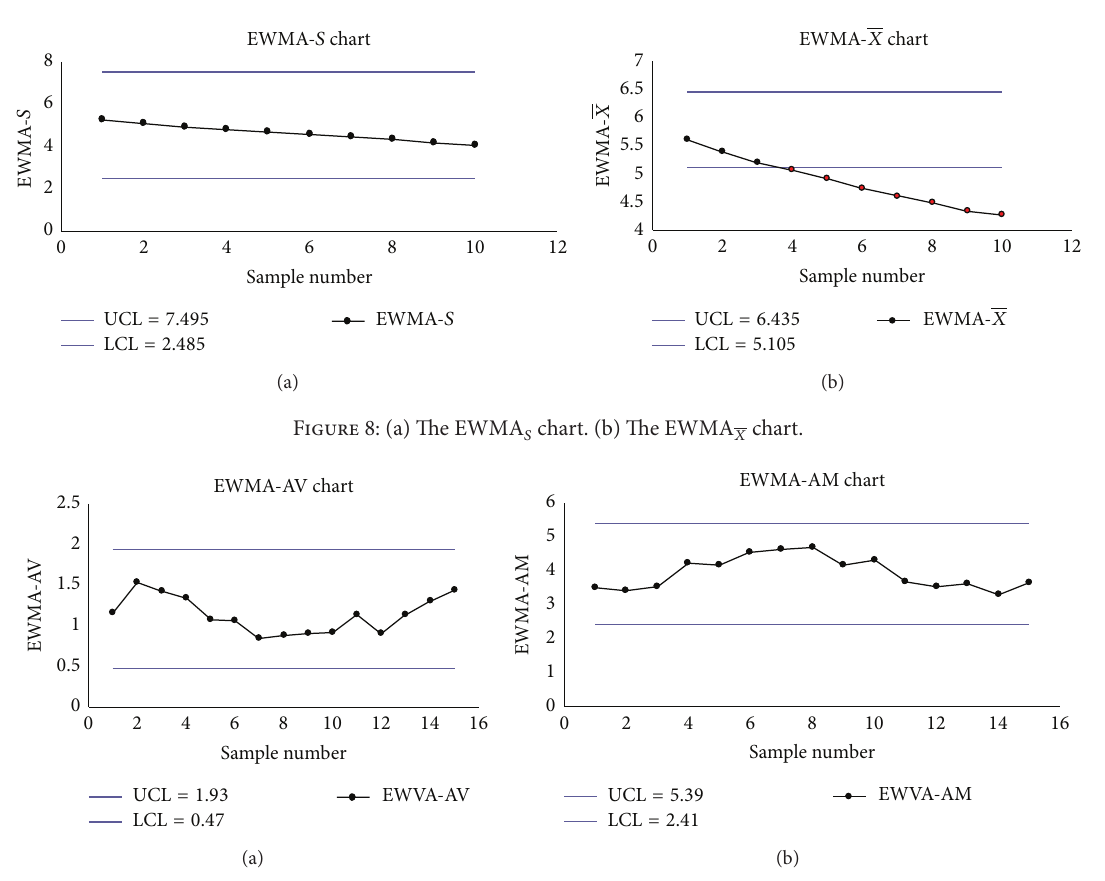
Figure 9: (a) The EWMA-AV chart with 𝜆 2 = 0.2 . (b) The EWMA-AM chart with 𝜆 1 = 0.2